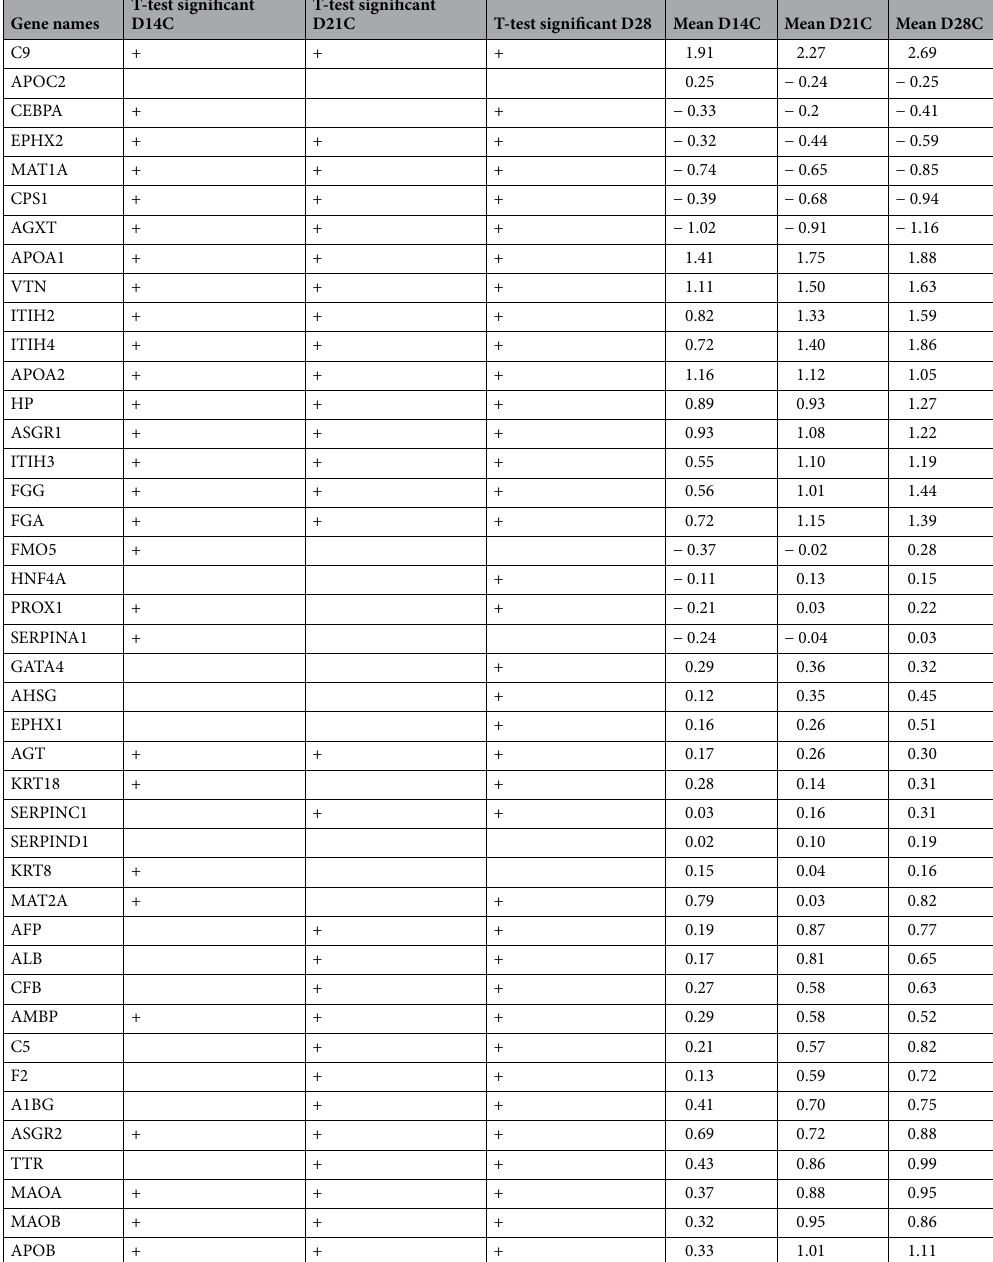
Table 1. Expression of proteins representative of a hepatic phenotype as compared to monolayers. 1 Values reported are the means, as Log2(x), of three biological replicate experiments showing relative fold change relative to monolayer counterparts. + indicates significance for q-value ≤ 0.05. Original non-averaged values may be found in Supplementary Table